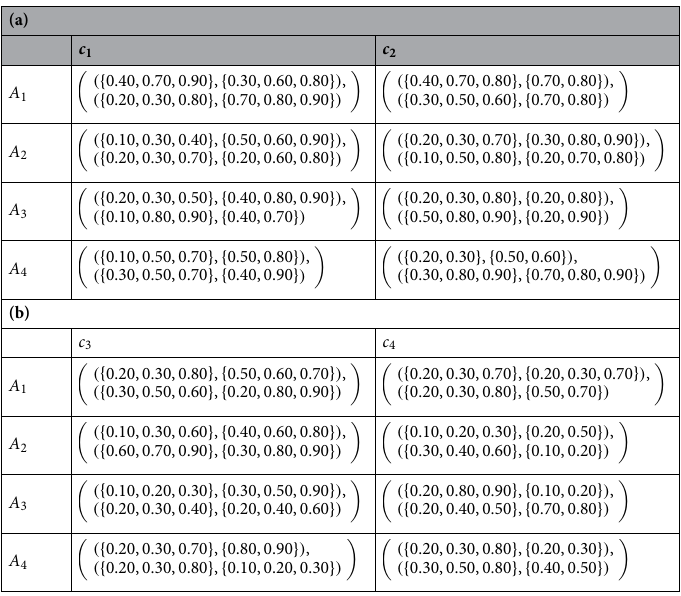
Table 4. Expert-3 information.